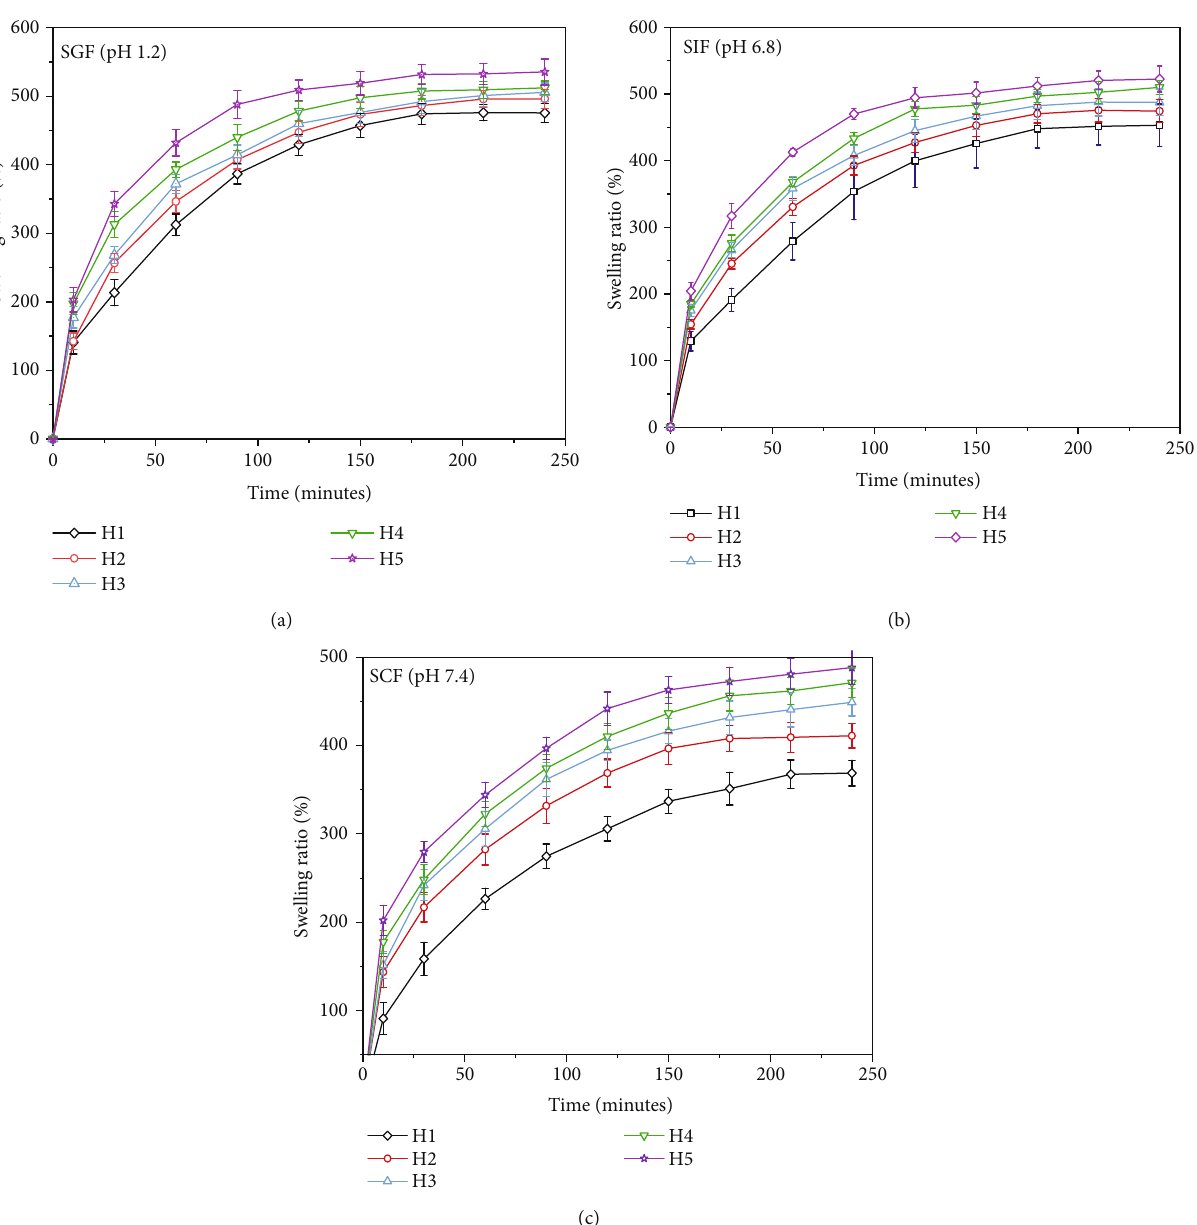
Figure 1: Swelling ratio of hydrogels H-1 to H-5 in (a) SGF, (b) SIF, and (c)